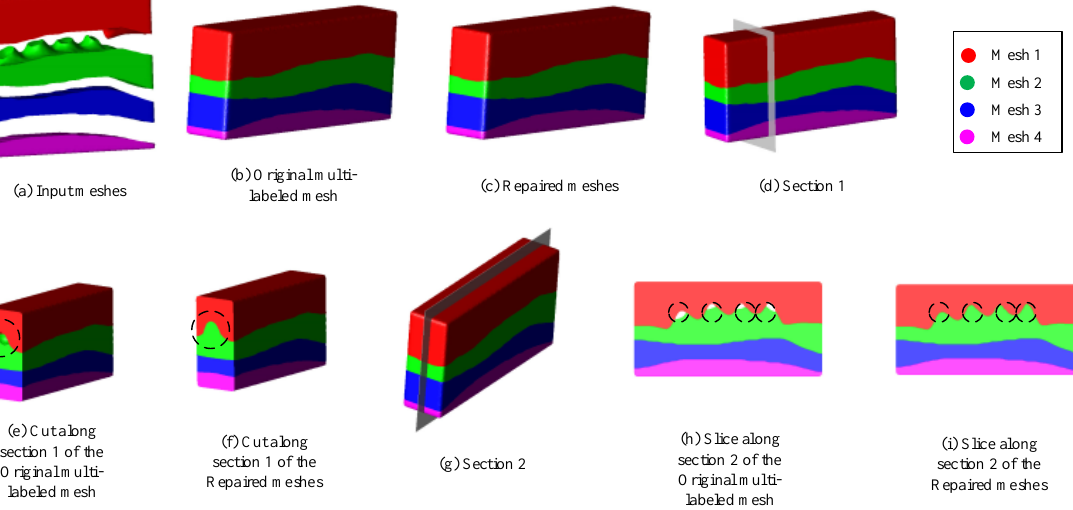
Figure 8. The multi-labeled mesh with input four sub-meshes.